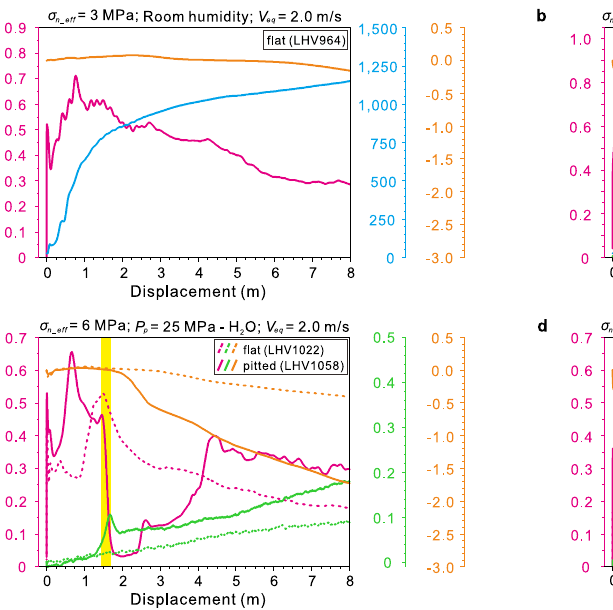
surfaces, either fl at or pitted (Supplementary Fig. S1d), were used in the experi- ments. The transient sharp weakening and the spike in bulk pore pressure coexist (yellow shading), although the bulk pressure rise should be much lower than that locally within the